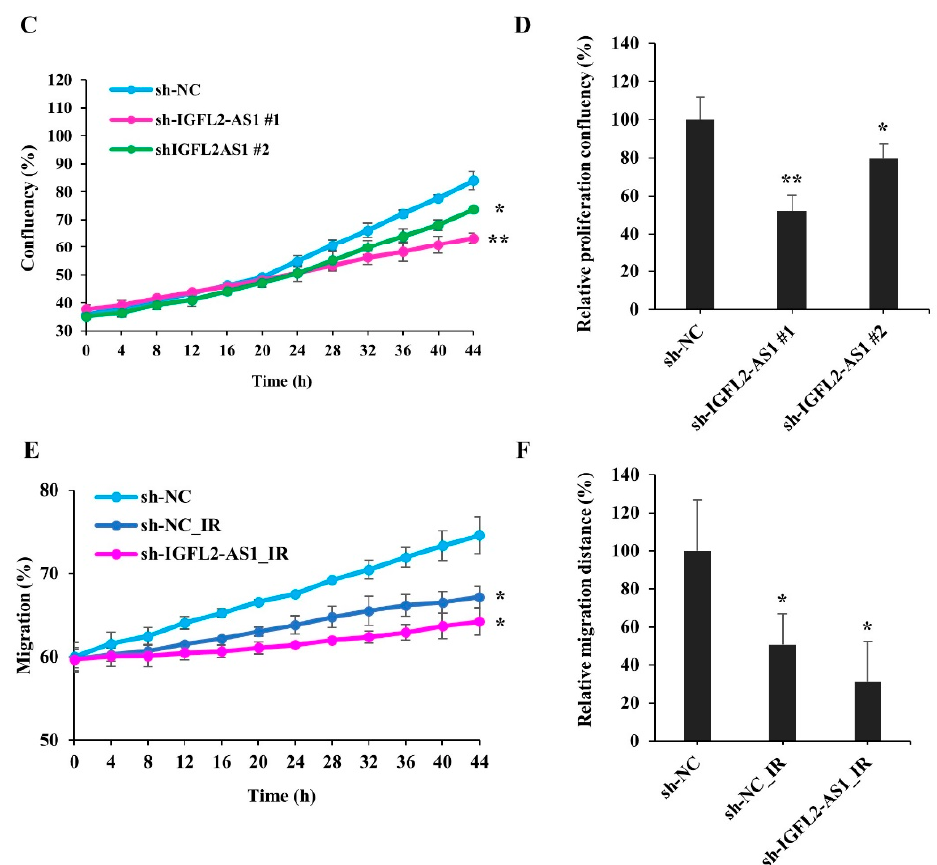
Figure 3. Radiation sensitivity is enhanced in IGFL2-AS1–knockdown CRC cell lines. ( A ) Viability of the indicated cell lines after irradiating with doses of 0, 3, 6, and 9 Gy, measured by MTT assay. Survival fractions were assessed 3 days after irradiation. Data are normalized to those of non- irradiated controls. ( B ) Colony formations after irradiating with doses of 0, 1.5, 3, Gy, measured by clonogenic assay. Colonies containing more than 50 cells were assessed 14 days after irradiation. Data were normalized to those of non-irradiated controls and the results are expressed as surviving fraction. ( C ) Proliferation rates of the indicated cell lines following exposure to 3 Gy irradiation (at 0 h). Digital images from the same field were acquired using a Celloger Mini Plus time-lapse microscopy system. The graph shows proliferation rates calculated over a 48-h period. ( D ) Graph showing proliferation rates of the indicated cell lines over a 48-h period after irradiation at a dose of 3 Gy (at 0 h). ( E ) Wound-healing assays performed using the indicated cell lines. Cells were irradiated at a dose of 3 Gy irradiation (at 0 h), and the scratched area was subsequently monitored for migrated cells using time-lapse microscopy. ( F ) Graph showing the rate of cell migration, measured over a period of 48 h after wounding and/or irradiating (at 0 h). Data are presented as means ± SD. Asterisk indicates the followings: * p < 0.05, ** p < 0.01, *** p < 0.001.